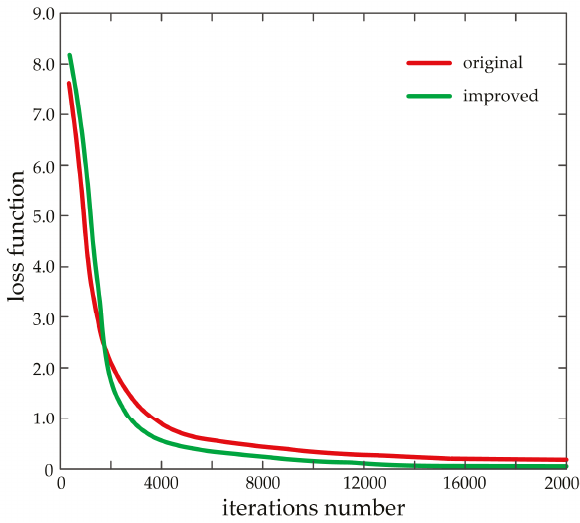
Figure 5. The loss functions of SSD before and after improvement.